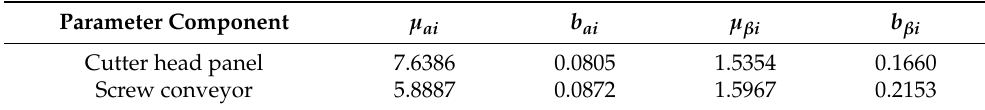
Table 9. Location and scale parameters for the cutter head panel and screw conveyor under the Gumbel distribution.